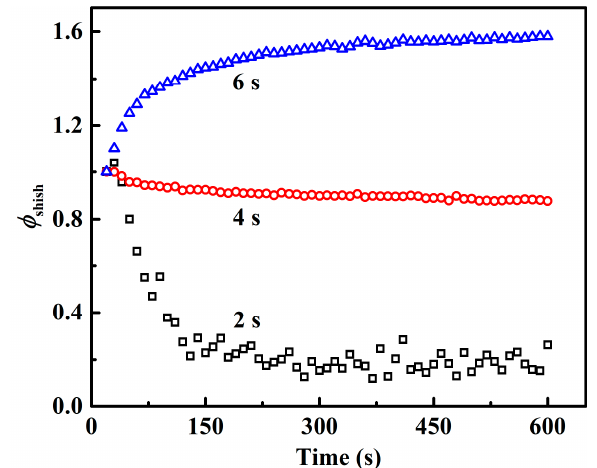
Figure 3. Time evolution of the relative shish integrated intensity under different shear conditions.